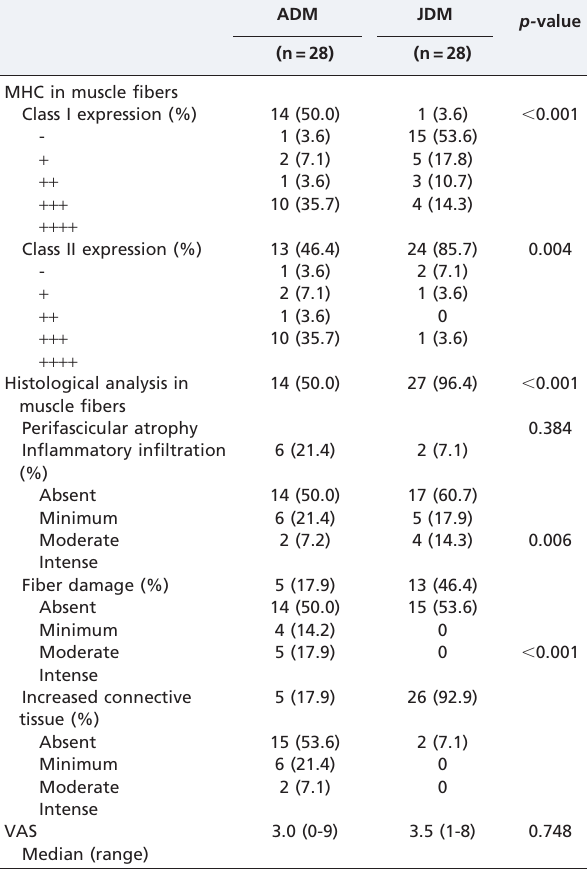
Table 2 - Immunohistological and histological analyses of muscle biopsies from untreated adult and juvenile dermatomyositis patients.